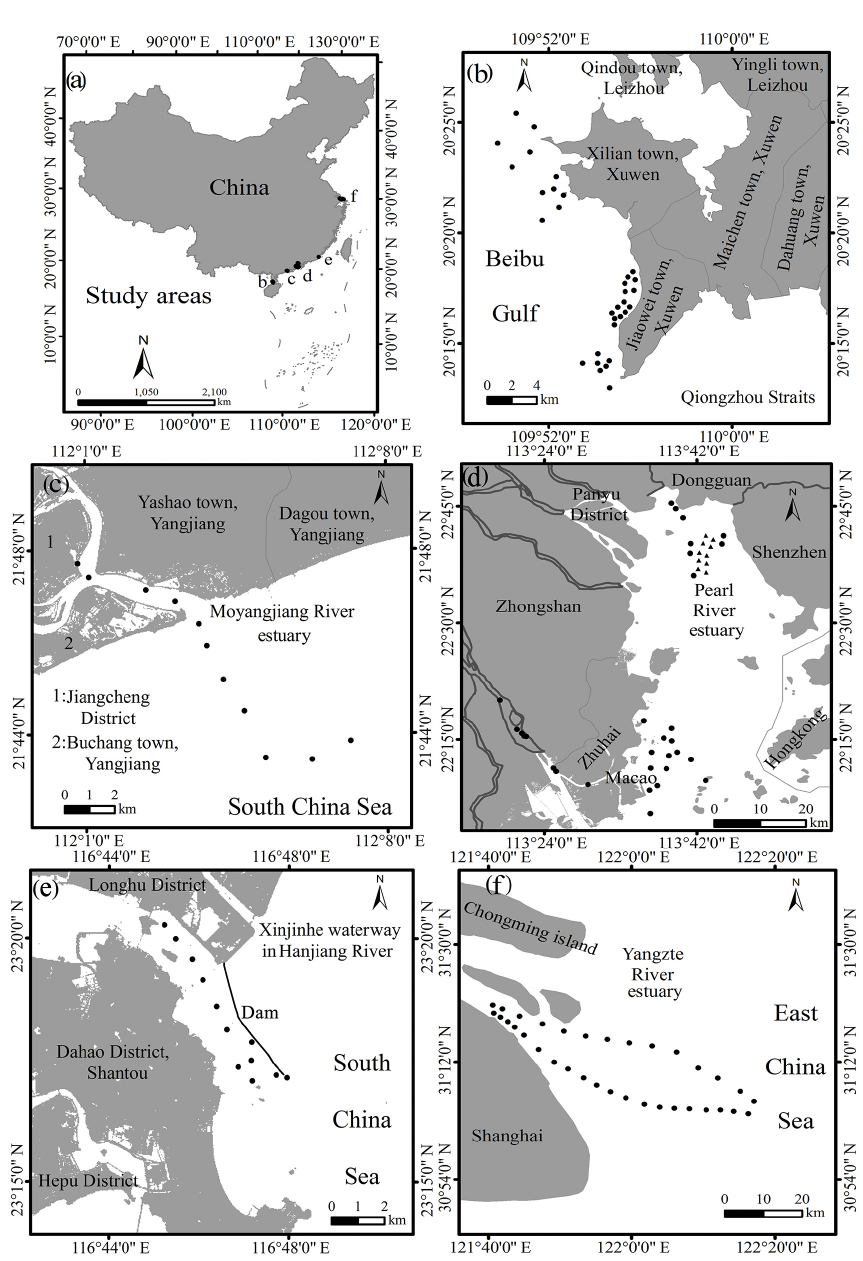
Figure 1. (a) Study areas and locations of in situ data (black dots and triangles). (b) Xuwen coast; (c) Moyangjiang River estuary; (d) Pearl River estuary; (e) Hanjiang River estuary; (f) Yangtze River